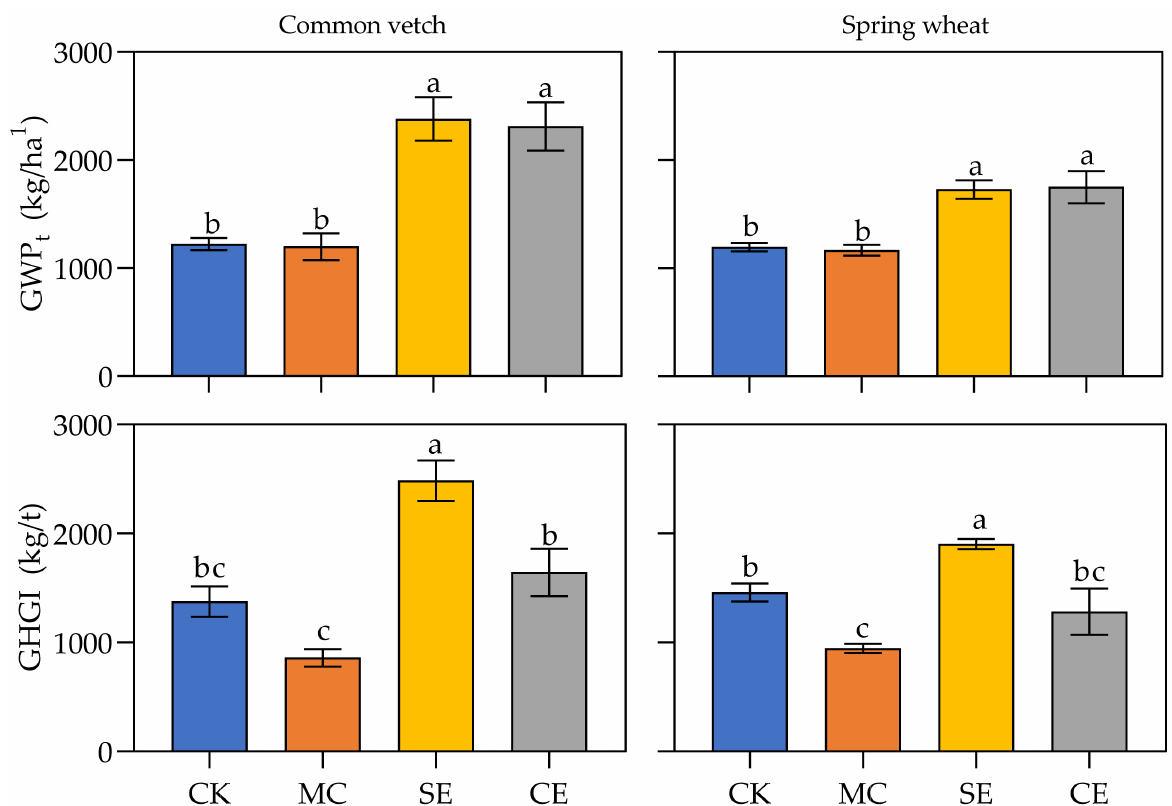
Figure 5. Global warming potential (GWP) and GHG emission intensity (GHGI) of two forage crops at two stages. The significant differences were labeled with letters using Duncan’s notation, from largest to smallest: a, b, c. If there is no significant difference between two values, the same or overlapping letters are used for both